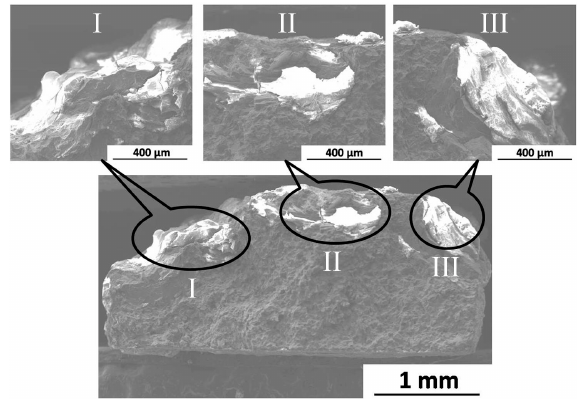
Figure 11. Fracture surface of the BM specimen after immersion for three days.